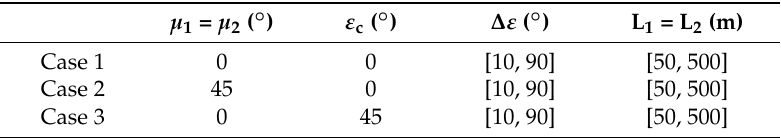
Table 1. Considered formation geometries.